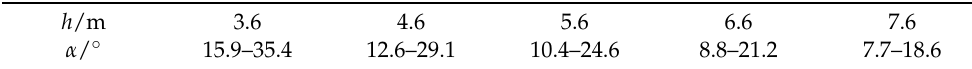
Table 1. Changes of α value at different h